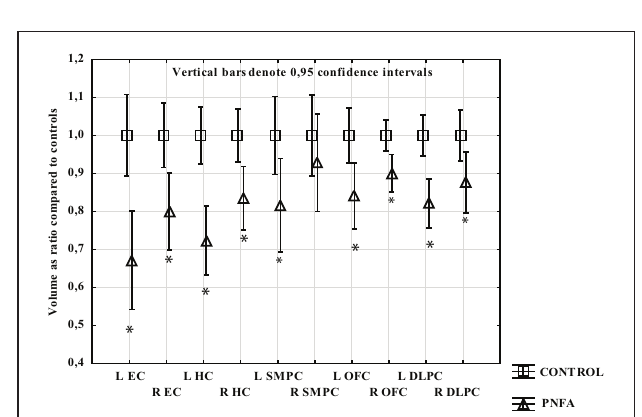
FIGURE 3 | The volume of measured region in PNFA expressed as a ratio of CTL volume. CTL volume is set to 1. X-axis denotes the included regions: EC, entorhinal cortex; HC, hippocampus; OFC, orbitofrontal cortex; SMPC, subcallosal medial prefrontal cortex; DLPFC, dorsolateral prefrontal cortex. ∗ p < 0 . 01.